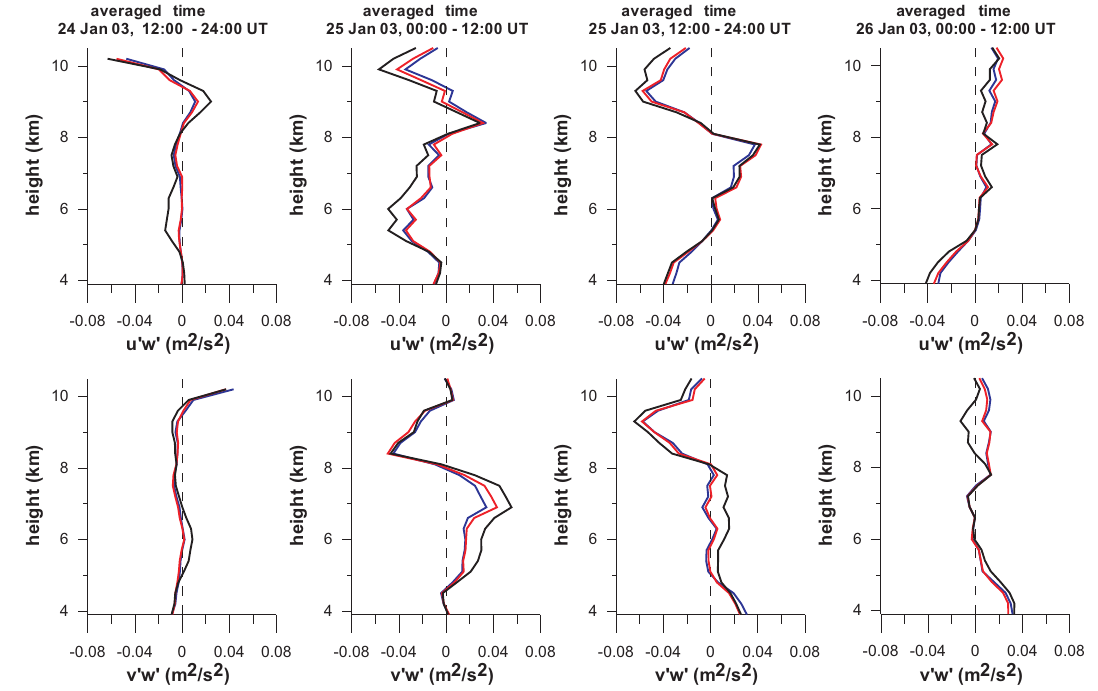
Fig. 8. Vertical fluxes of zonal (upper panel)and meridional (lower panel) momenta derived from the radar measurements at Andenes in January 2003 using direct approach (black), symmetric-beam (red) and hybrid (blue)